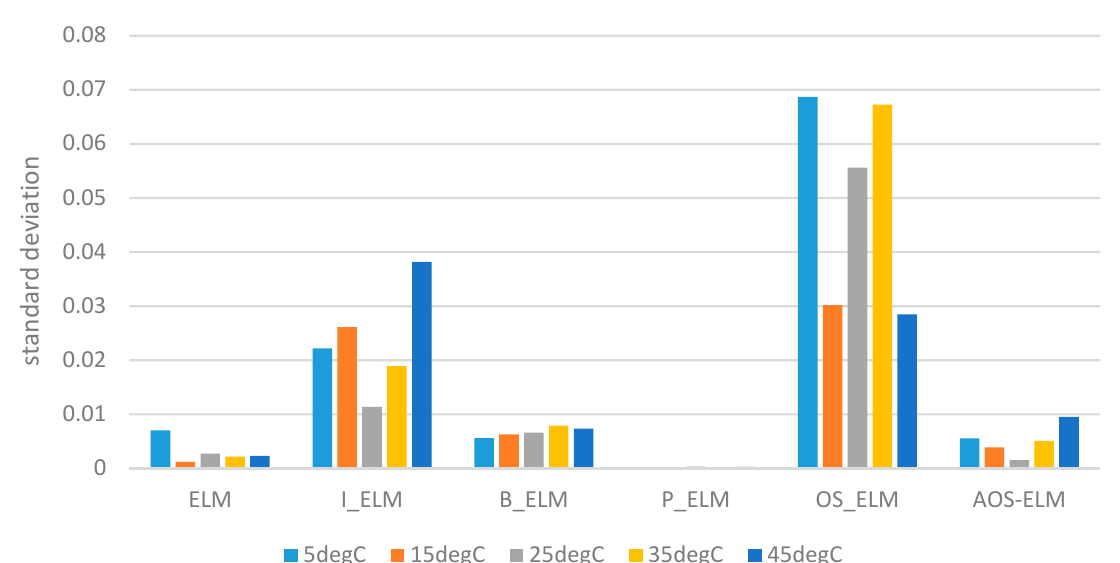
Figure 18. SOC standard deviation of adaptive online sequential ELM (10 neurons).